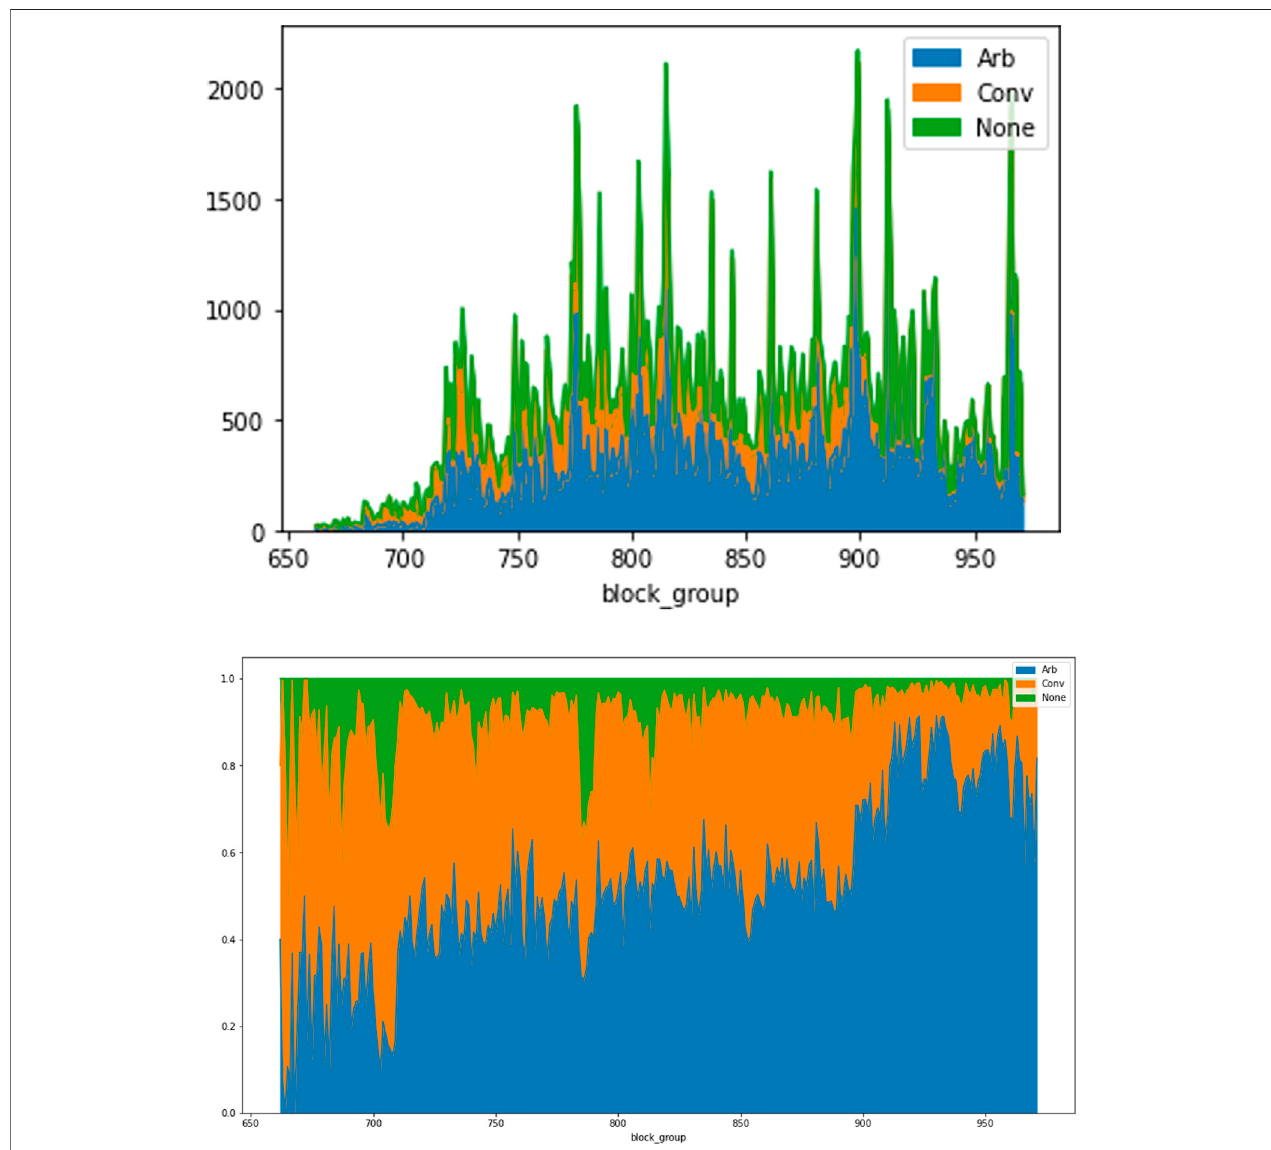
FIGURE 2 | Uniswap Trade Classi fi er Estimation, Retail Precision (4dp) of Convenience and Arbitrage trades in counts and percentages per